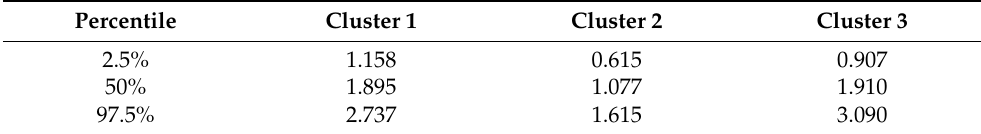
Table 3. Bootstrap confidence intervals of 95% and medians for average annual SEUS landfalling tropical cyclones, broken down by cluster. If the median bootstrap replicate falls outside the interval for the other clusters, the difference was deemed statistically significant. Here, cluster 2 is significantly different than clusters 1 and 3, though clusters 1 and 3 are not statistically significantly